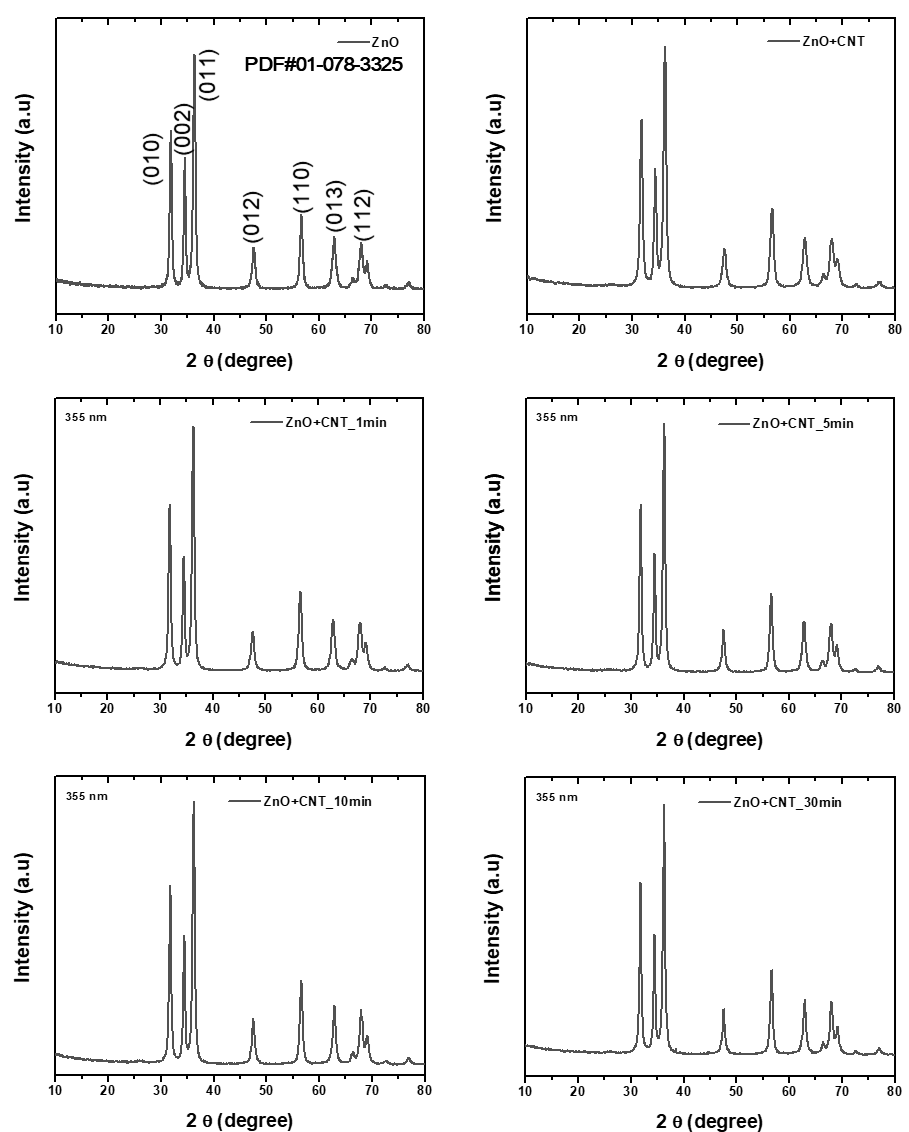
Catalysts 2019 , 9 , x FOR PEER REVIEW Figure 4. XRD patterns of ZnO NS and ZnO-CNT hybrids prepared in different PLA conditions. Figure 4. XRD patterns of ZnO NS and ZnO-CNT hybrids prepared in di